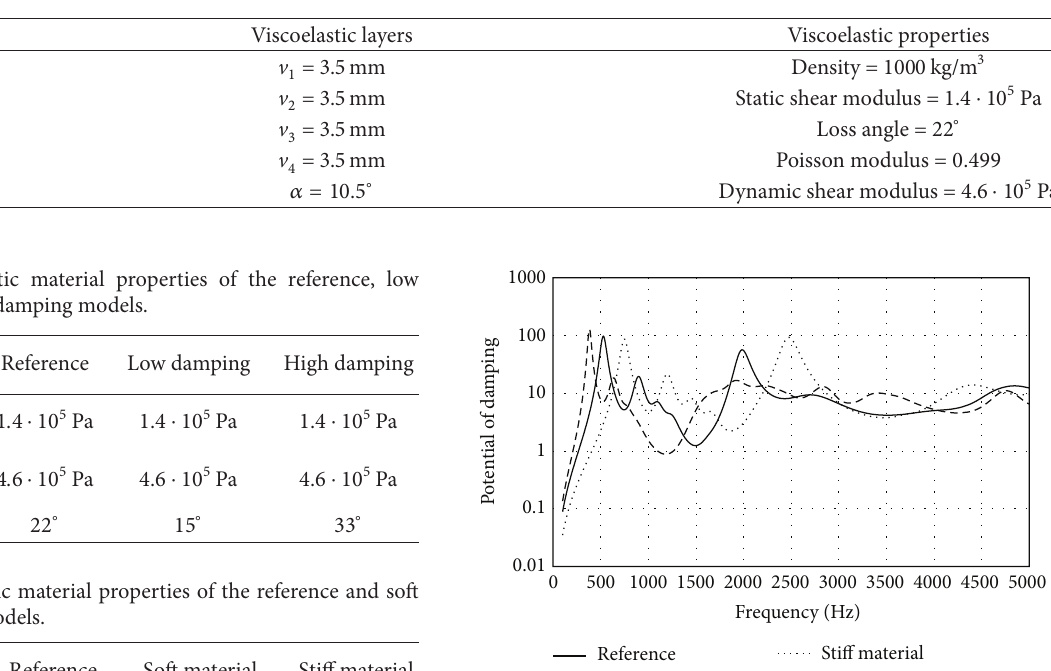
Table 2: Geometric parameters of the reference four-layer damper design.